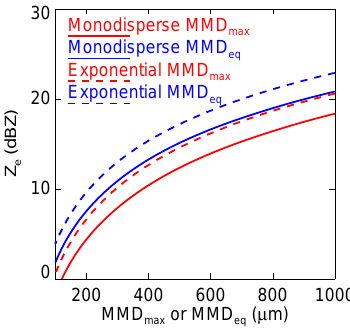
Figure 1. For an ice water content of 4gm − 3 with a monomodal ice number size distribution that is either monodisperse or exponential in shape, equivalent radar reflectivity ( Z e ) as a function of mass median maximum dimension (MMD max ) for ice particle properties following Baker and Lawson (2006, their Table 1) and mass me- dian area-equivalent diameter (MMD eq ) for ice particle properties following Eq. (1) (Locatelli and Hobbs,